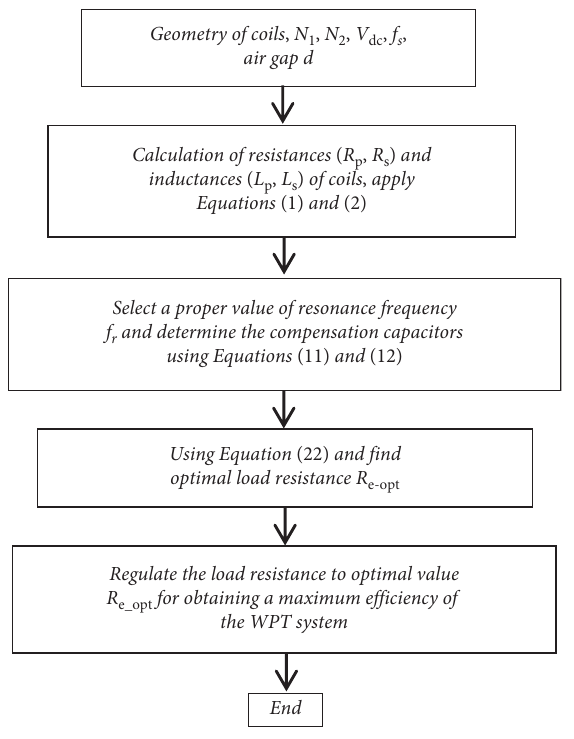
Figure 7: Flow diagram describing the principal steps to design a WPT system. Table 2: Main parameters of the experimental test system. Dimension of the transmitter coil